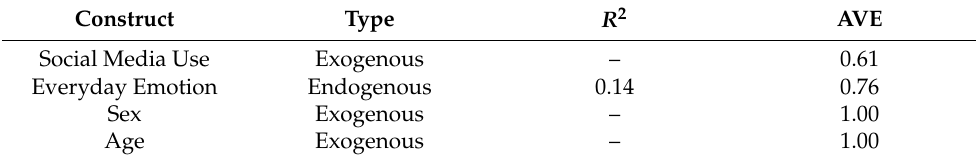
Table 9. Structural model summary.